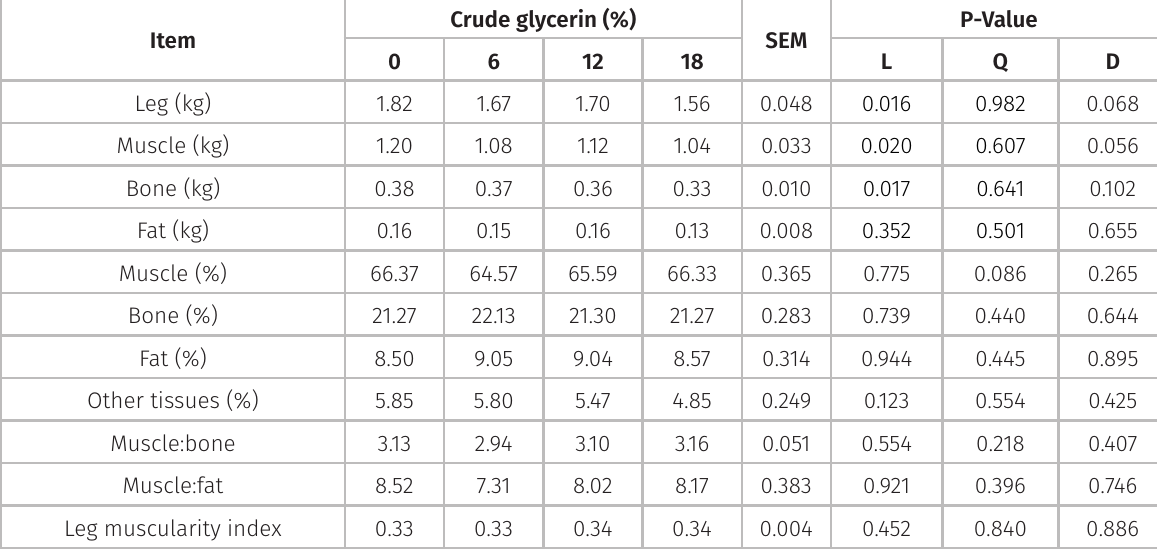
Table IV. An economic evaluation of goats fed diets containing increasing levels of crude glycerin containing 63.06% glycerol and 45.57%